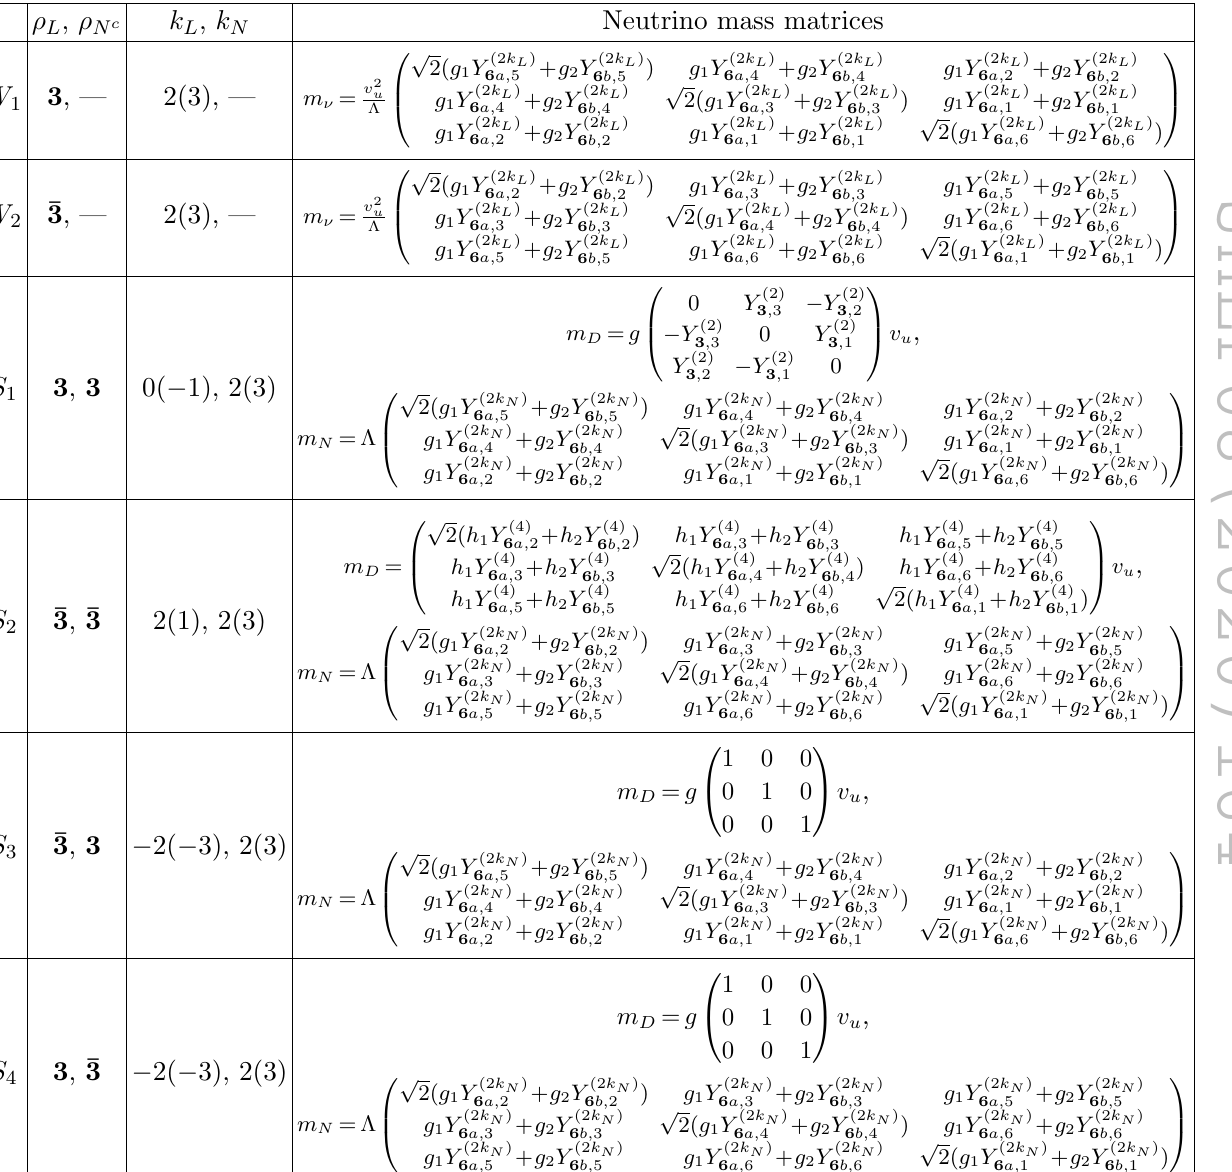
Table 3 . The predictions for the neutrino mass matrices, where only lower modular weight as- signments are displayed. The models in which neutrino masses are generated through Weinberg operator and seesaw mechanism are denoted as W 1 ; 2 and S 1 ; 2 ; 3 ; 4 respectively.